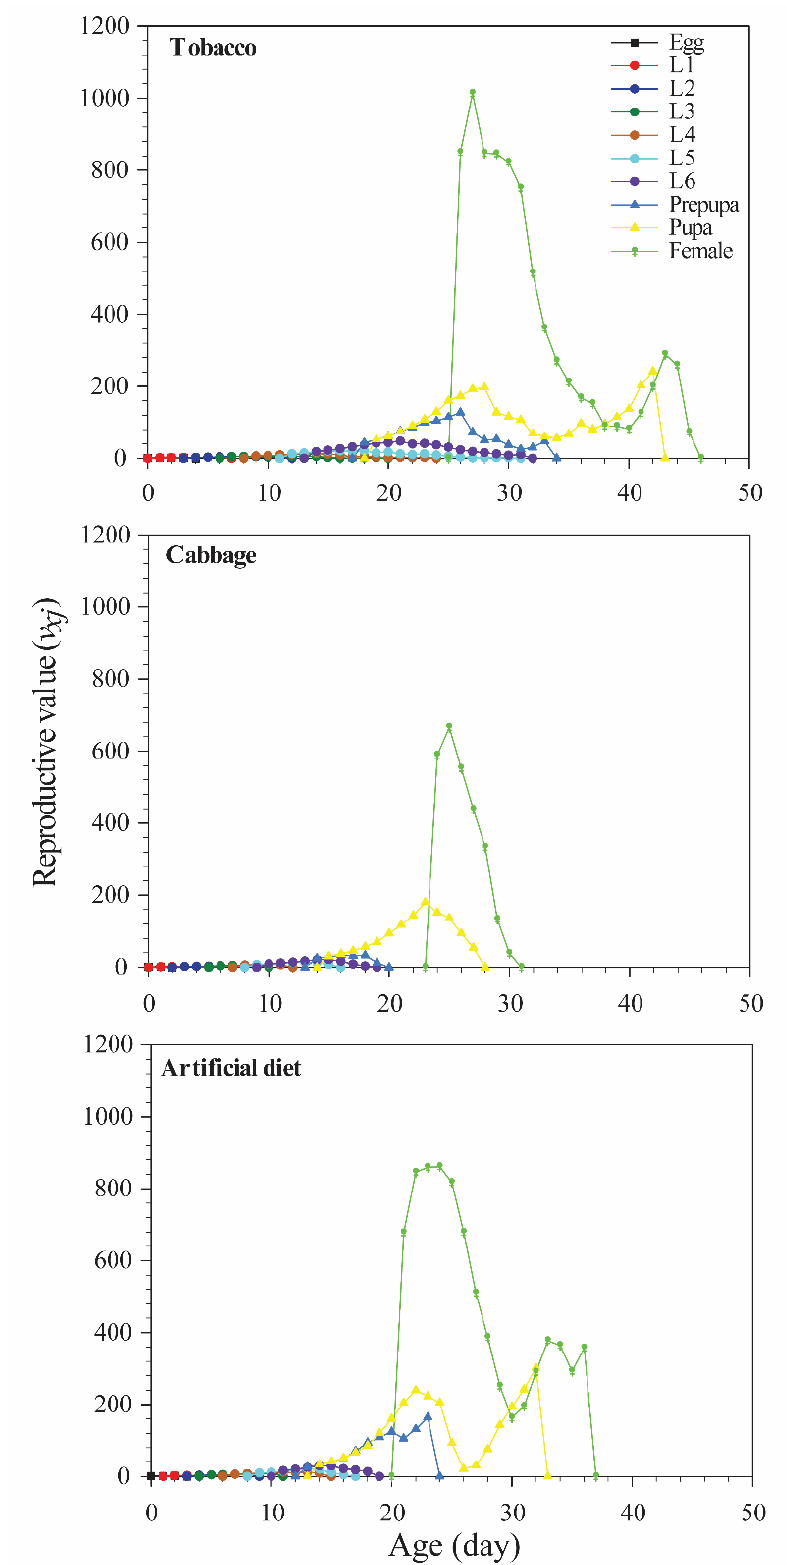
Figure 4. Age-stage-specific reproductive value ( v xj ) of Spodoptera litura reared on different diets.